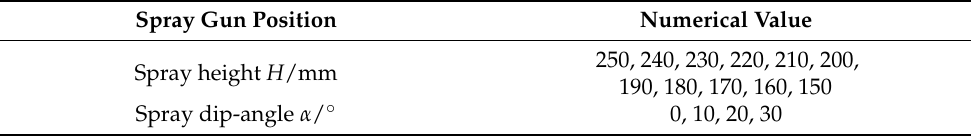
Table 1. Spray test parameters.